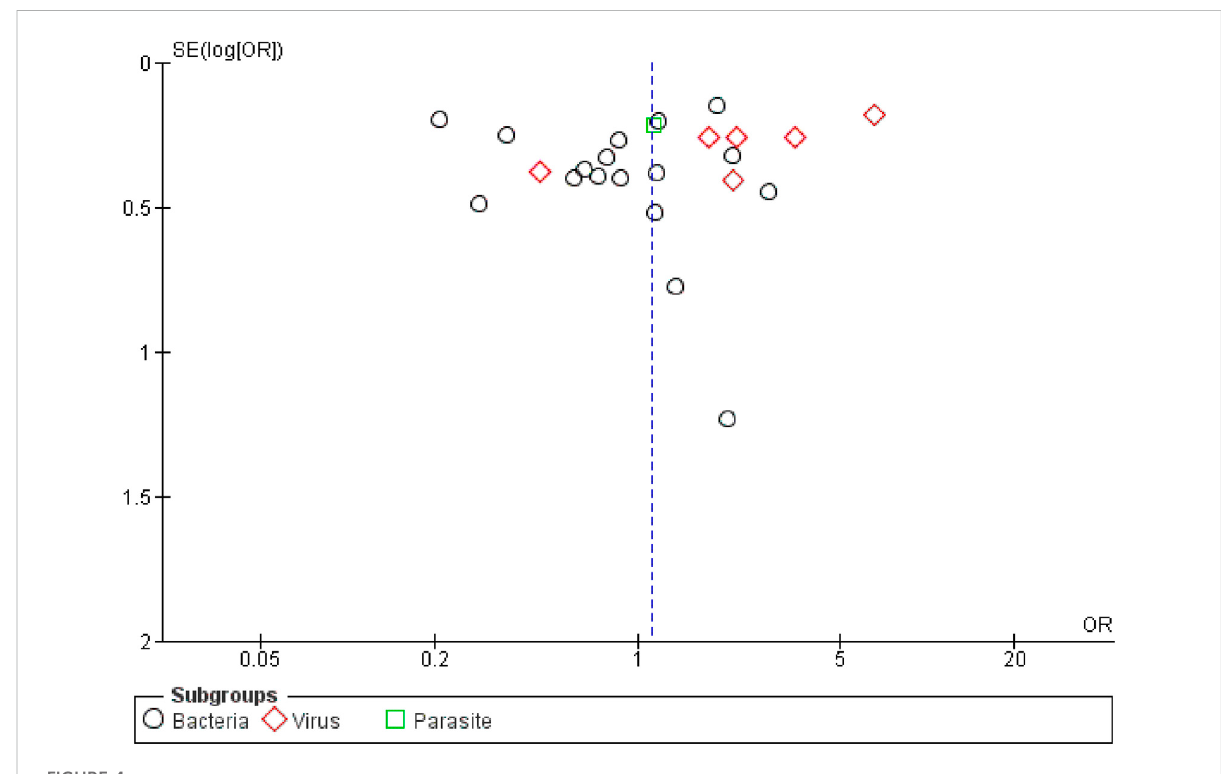
FIGURE 4 Begg ’ s funnel plot for the meta-analysis of the rs4986790 SNP of the TLR4